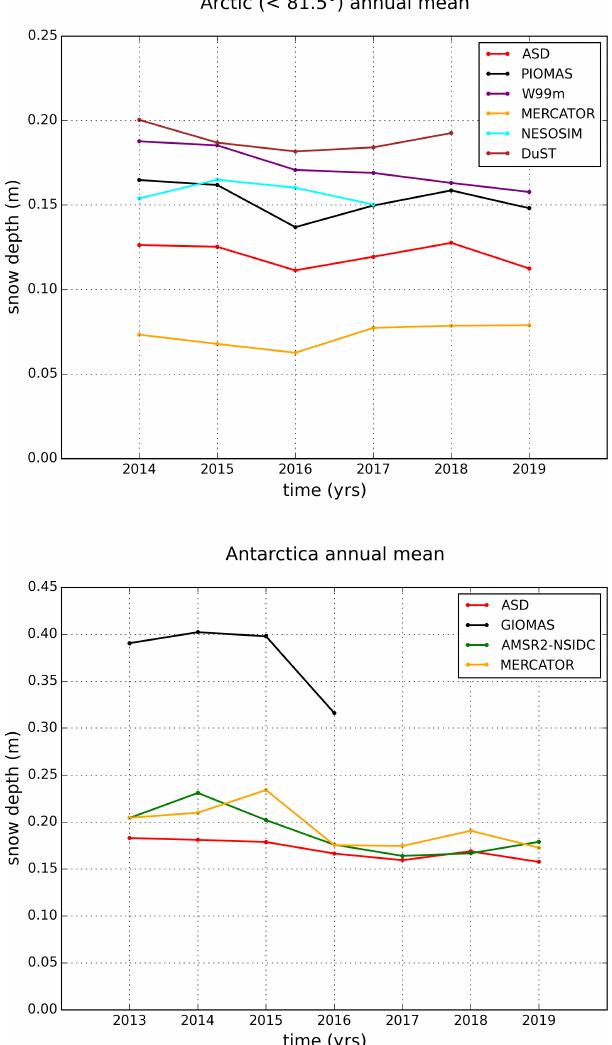
Figure 2. Times series of annual mean snow depth of the differ- ent products in both hemispheres. Annual means are calculated as the average of the spatial means of all monthly grid maps.